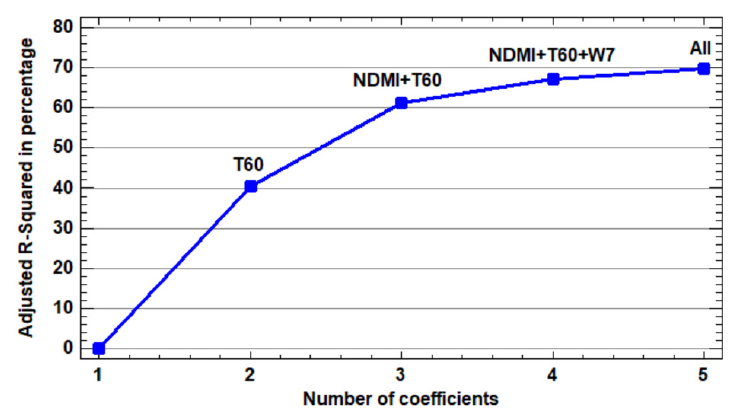
Figure 6. Adjusted R-squared (in %) for LFMC_WAS as a function of the number and the type of predictors included in the